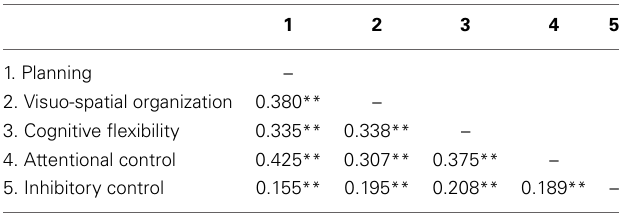
Table 7 | Correlations for dependent variables in the